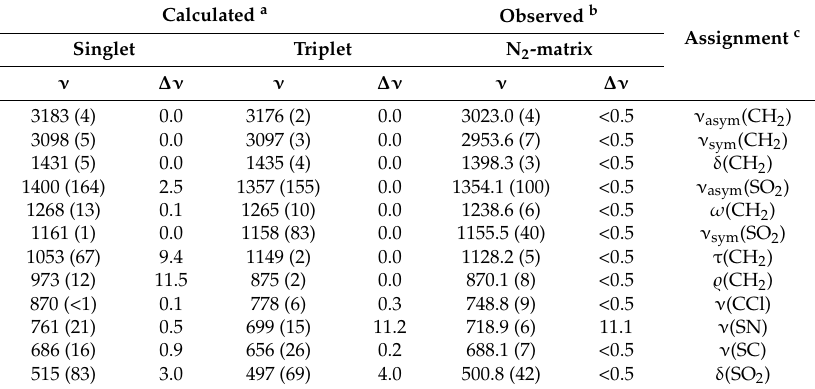
Table 1. Calculated and observed IR frequencies (>500 cm − 1 ) of CH 2 ClS(O) 2 N. Calculated a Observed